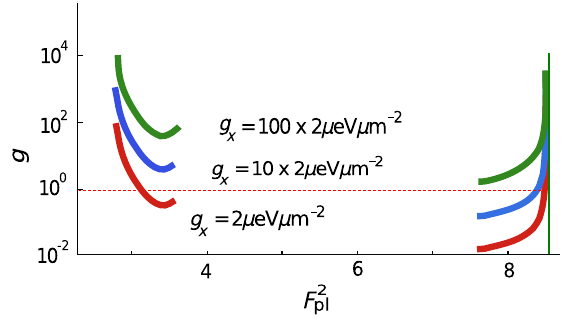
the exciton-exciton